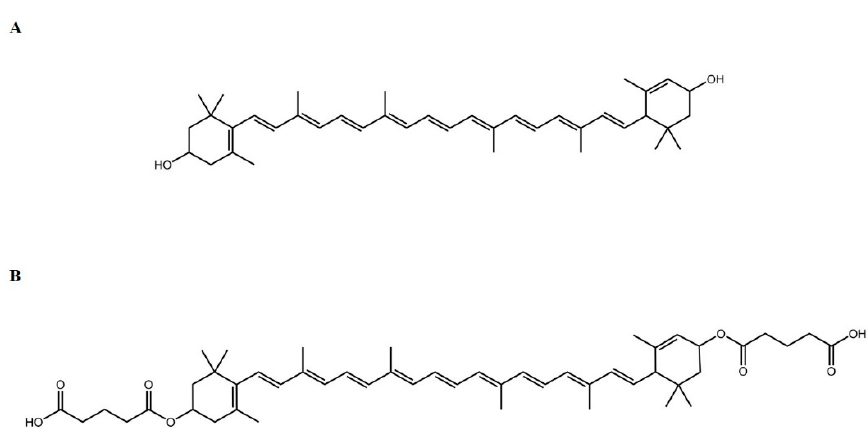
Figure 1. Structure of compounds used in the present study. ( A ) Parent drug Lut; ( B ) Prodrug lutein diglutaric acid (Lut-DG).